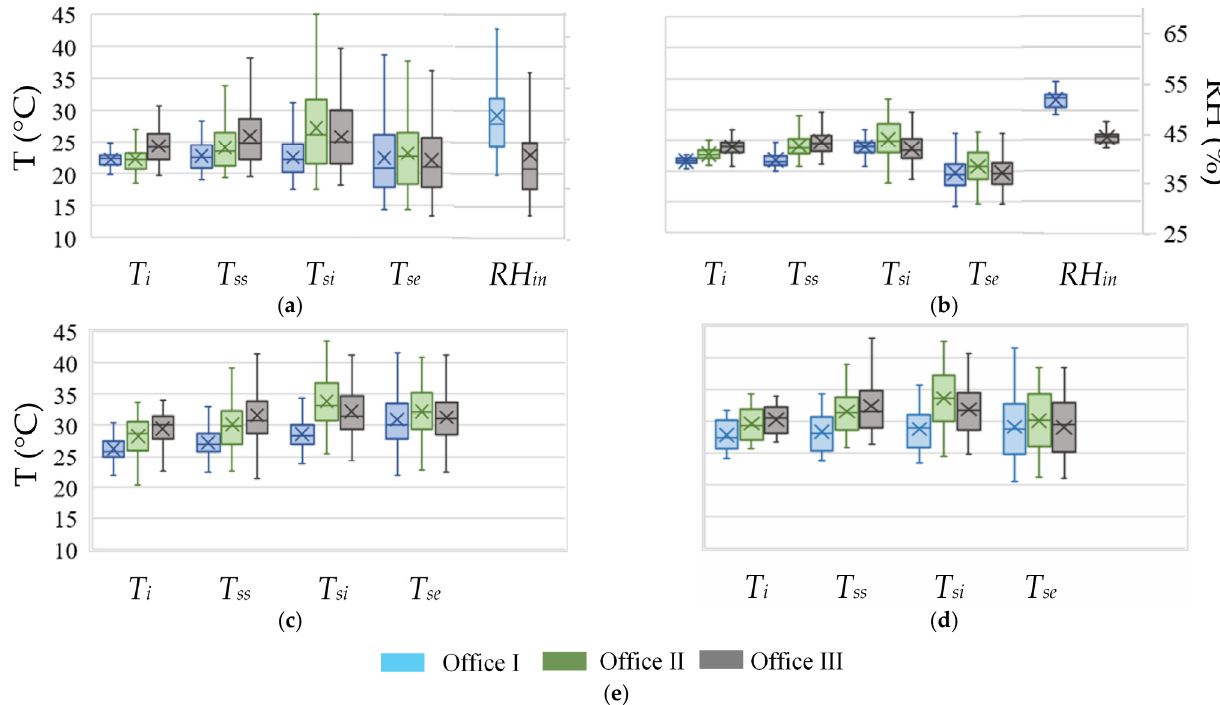
Figure 8. Experimental results of the hygrothermal performance of the offices based on data of working hours (between 9 a.m. and 6 p.m.) from days when the variable refrigerant volume (VRV) unit was turned on (weekdays—( a , c )) and off (weekends— b , d ) in the heating ( a , b ) and cooling ( c , d ) periods, using a color legend ( e ): indoor air temperature, T i ; shading slats surface temperature, T ss ; internal glass surface temperature, T si ; external glass surface temperature, T se ; relative humidity, RH in.